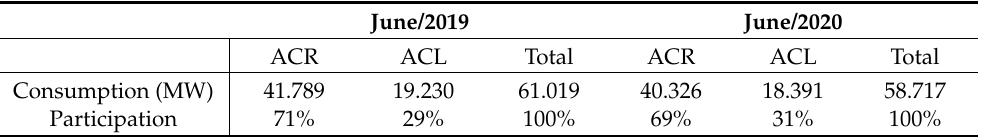
Table 1. Consumption and participation of electric energy contracting environments in